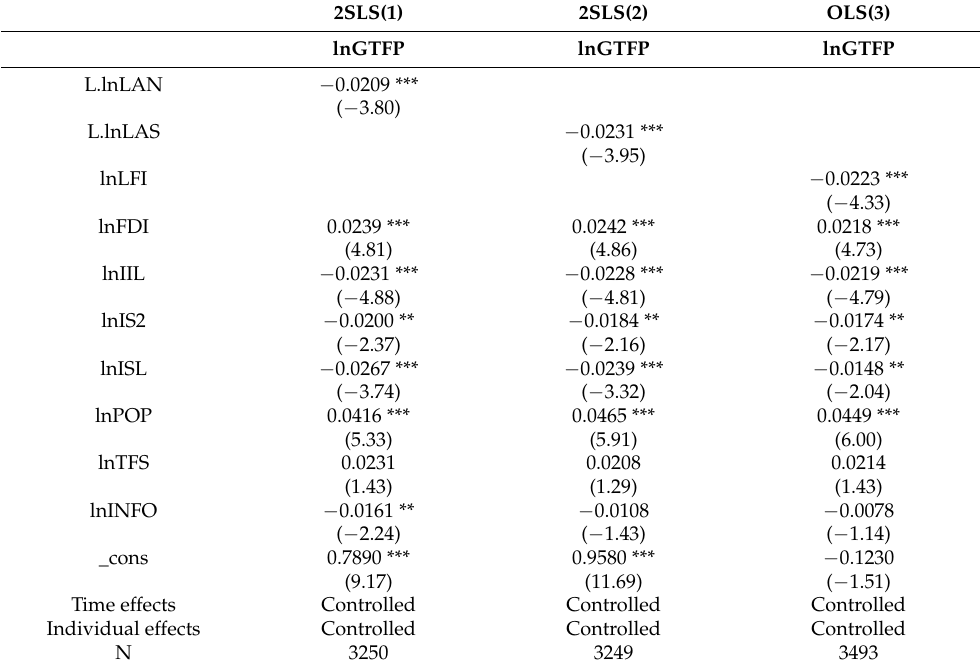
Table 11. Empirical results of robustness